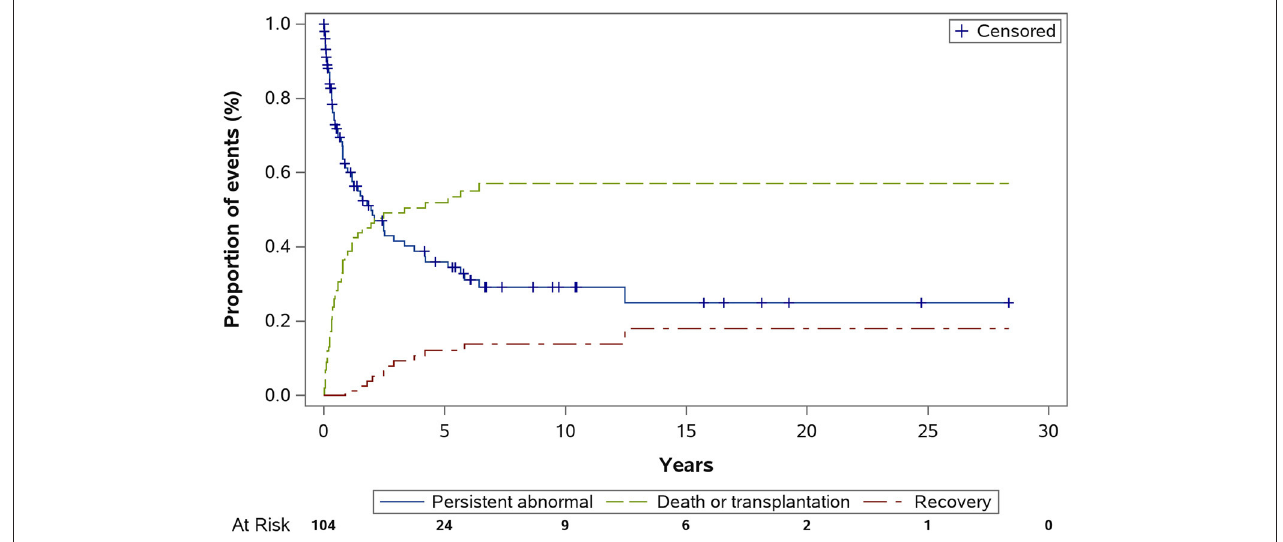
FIGURE 2 | Cumulative incidence of left ventricular normalization (recovery) in patients with primary dilated cardiomyopathy (Competing risk factors, death or transplant).